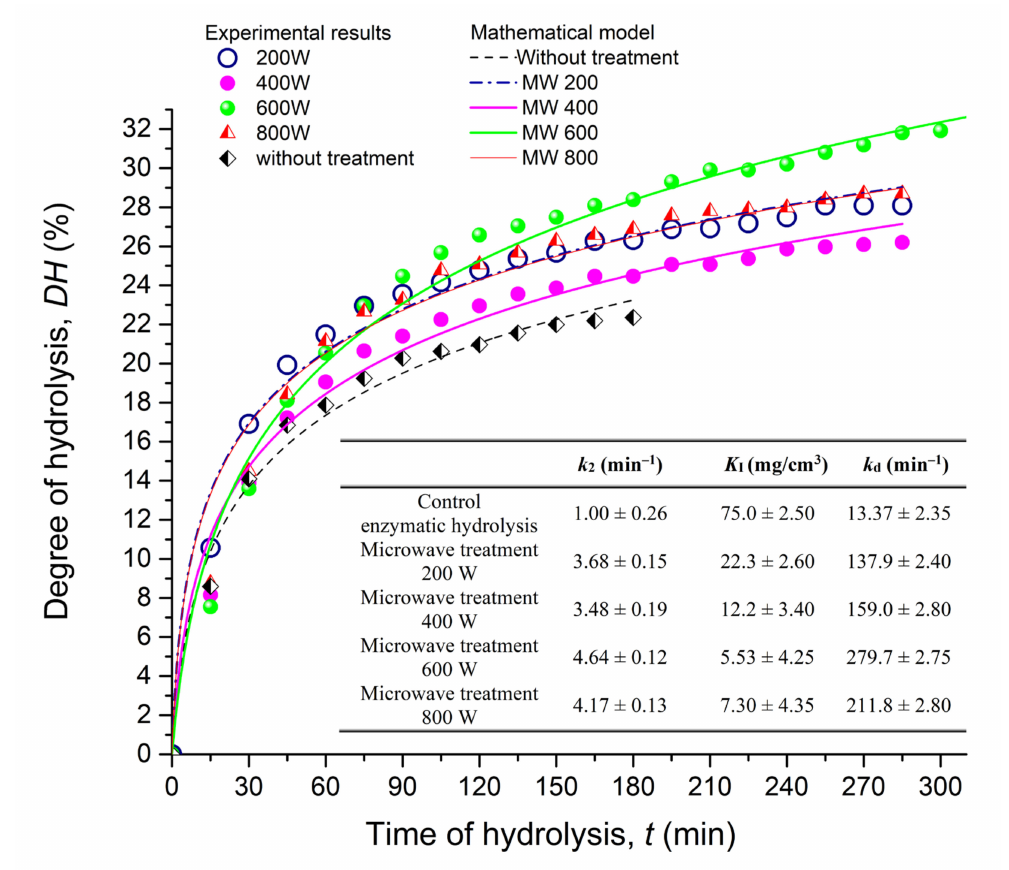
Figure 2. Comparison of the susceptibility of differently microwave treated gluten proteins to enzymatic hydrolysis conducted with commercial food-grade protease, Alcalase. The experimental results were fitted by using the empirical kinetic model with substrate inhibition and enzyme deactivation. Reaction conditions for hydrolysis of presented curves: gluten concentration 2% ( w / w ), E / S ratio 5%, temperature 60 ◦ C and pH 8). Inserted table—Values of the kinetic constants for enzymatic hydrolysis of microwave pretreated gluten